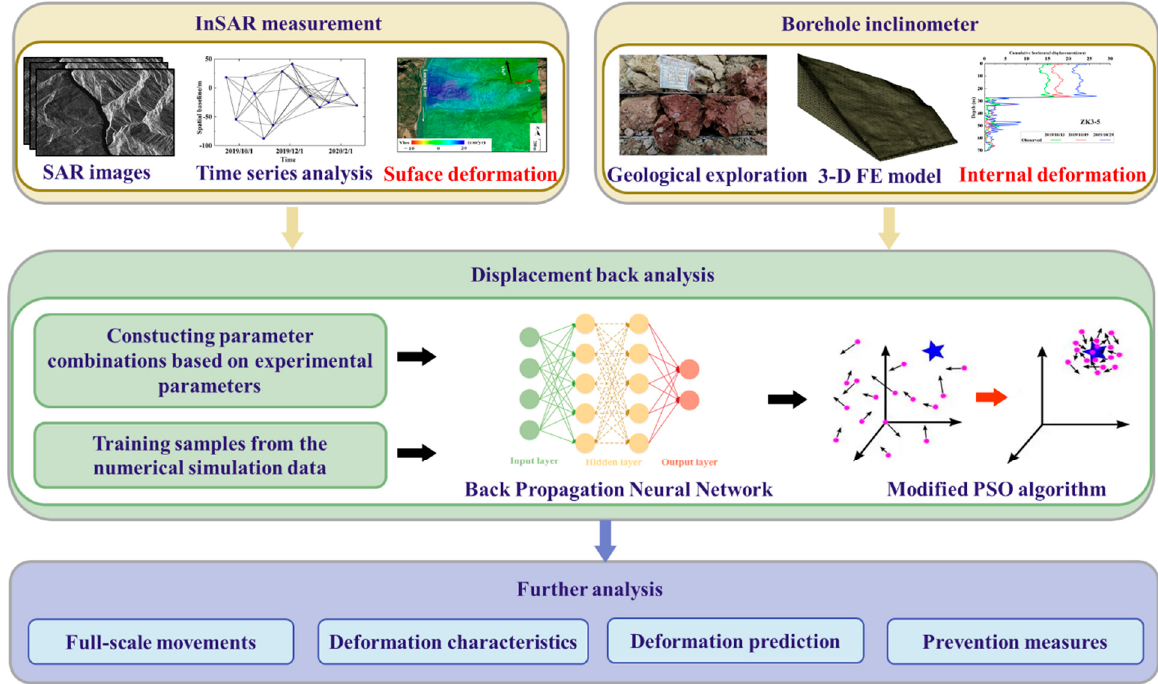
Figure 3. Flowchart of this study.